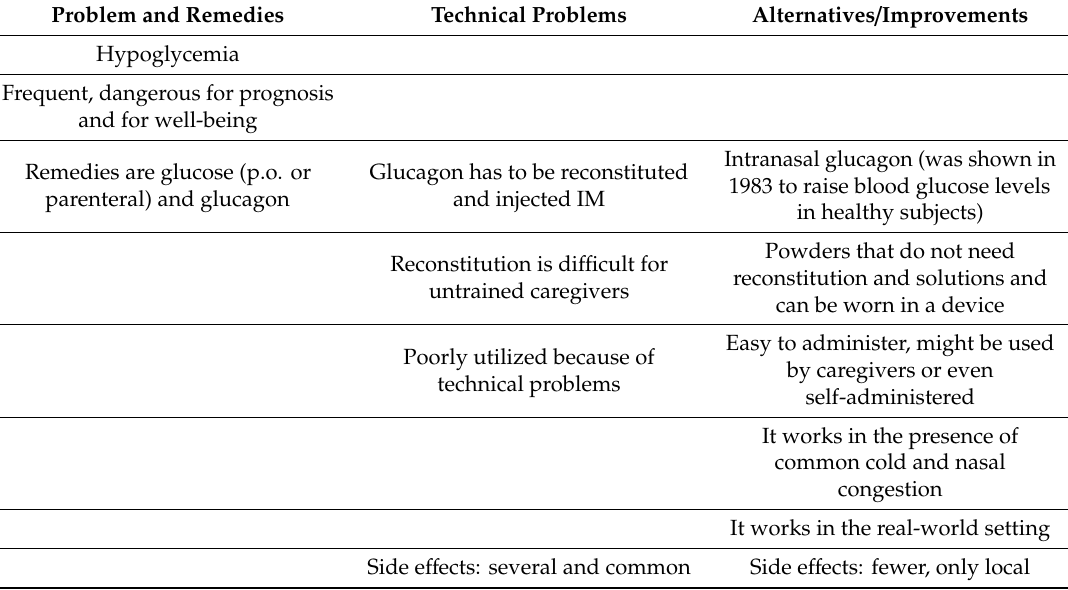
Table 1. Hypoglycemia in insulin treated patients with diabetes. The problems, the remedies, and the possible improvements.